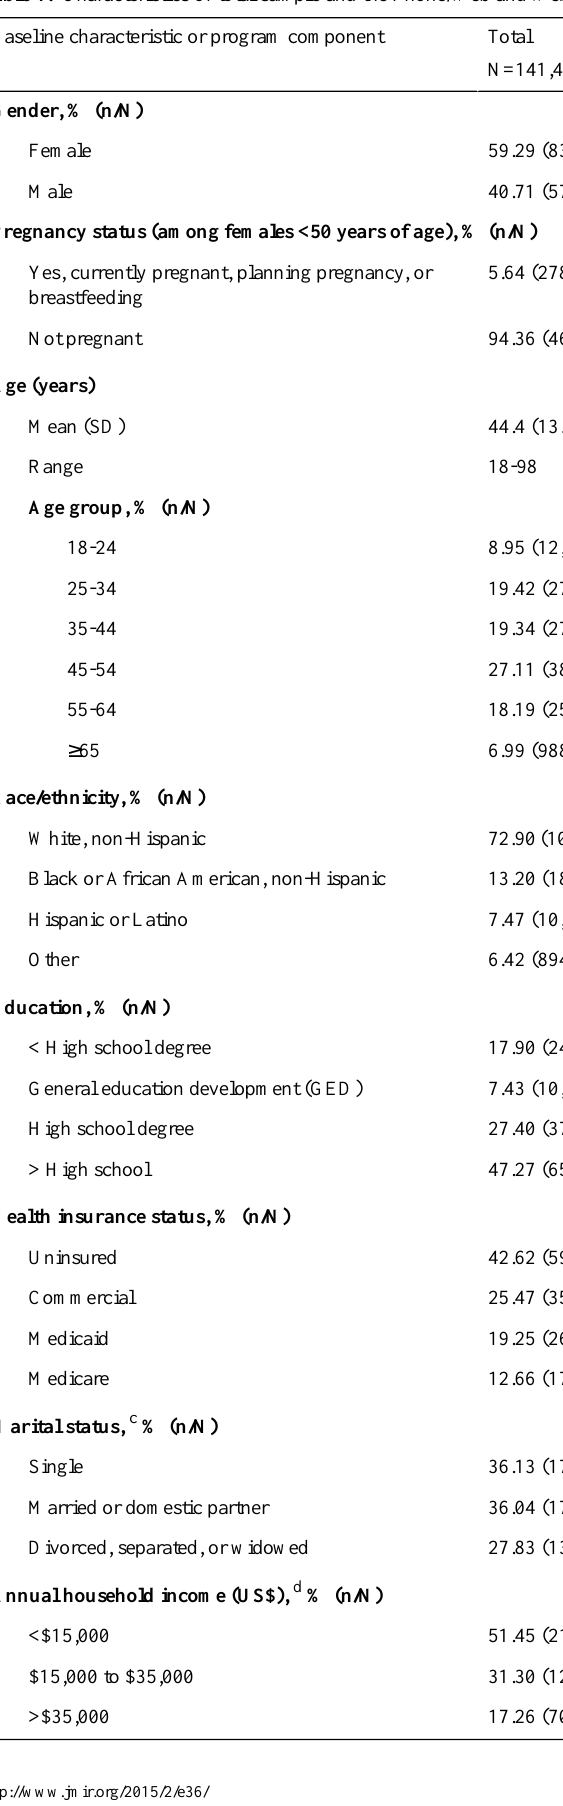
Table 1. Characteristics of total sample and the Phone/Web and Web-Only programs (N=141,429 a